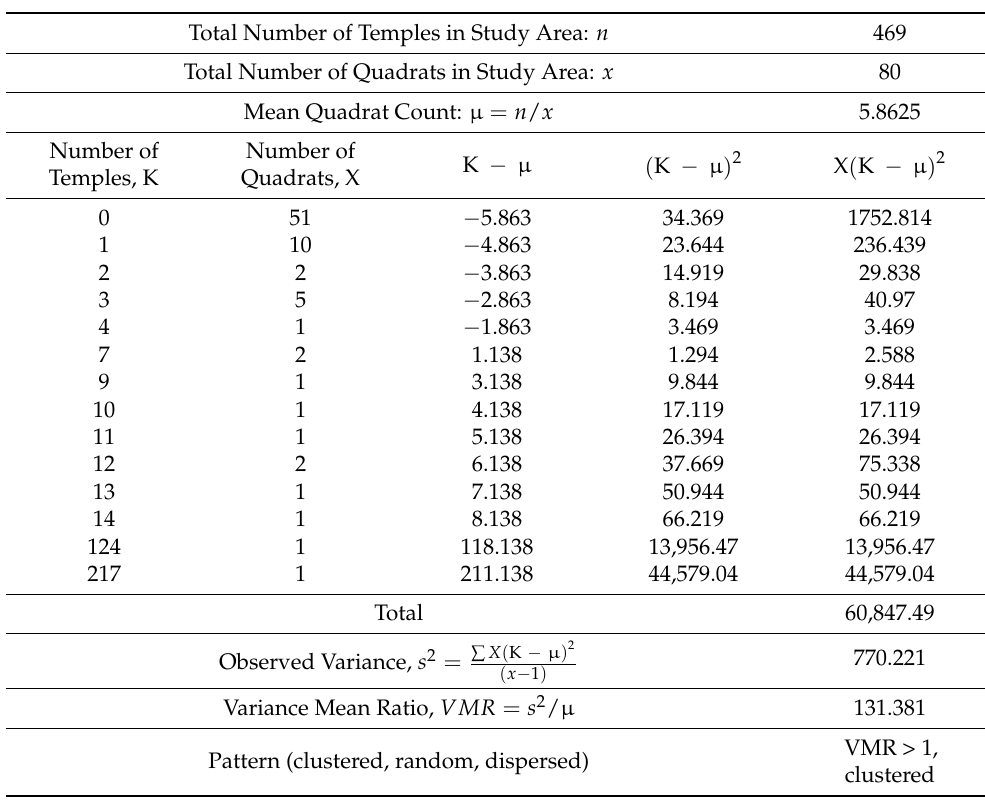
Table 1. The variance of the Buddhist temple data